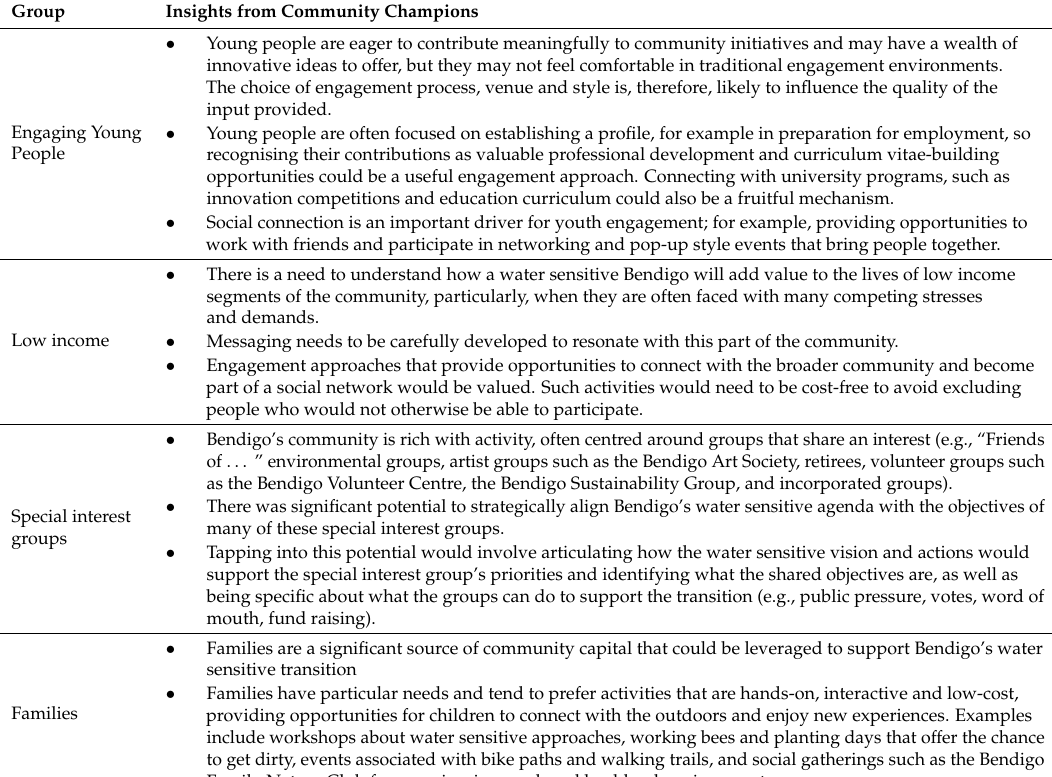
Table 2. Community champion suggestions for engaging diverse